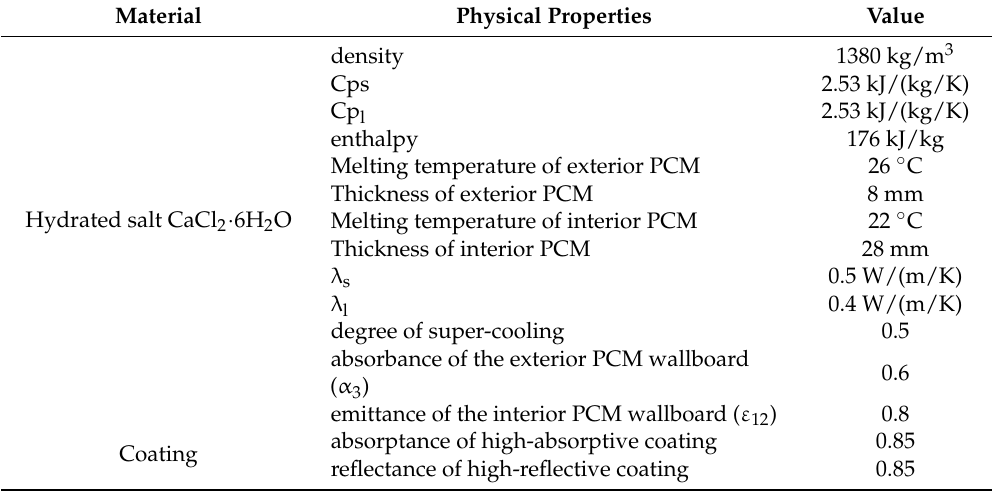
Table 1. Thermo-physical properties of the PCMs-VTW system